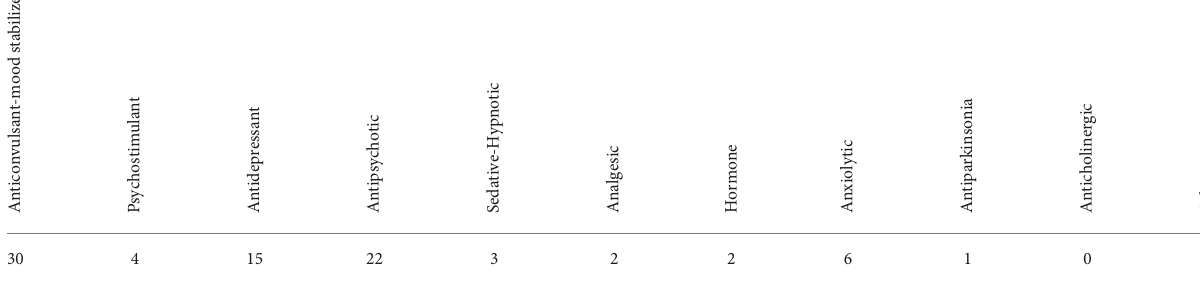
TABLE 2 Bipolar disorder (BD) patients by medication table